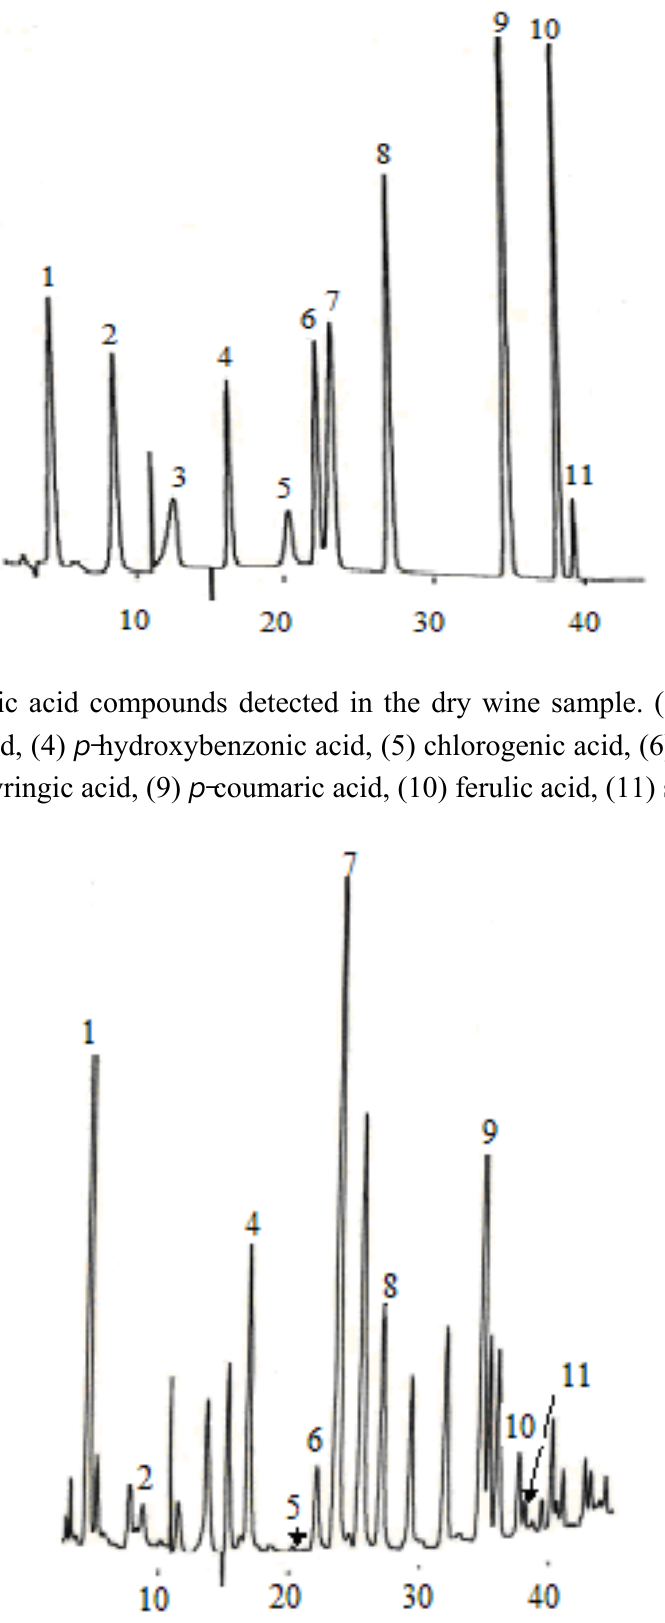
Figure 1. Chromatogram of 11 phenolic acid standards. (1) gallic acid, (2) protocatechuic acid, (3) gentisic acid, (4) p- hydroxybenzonic acid, (5) chlorogenic acid, (6) vanillic acid, (7) caffeic acid, (8) syringic acid, (9) p- coumaric acid, (10) ferulic acid, (11) sinapic acid.